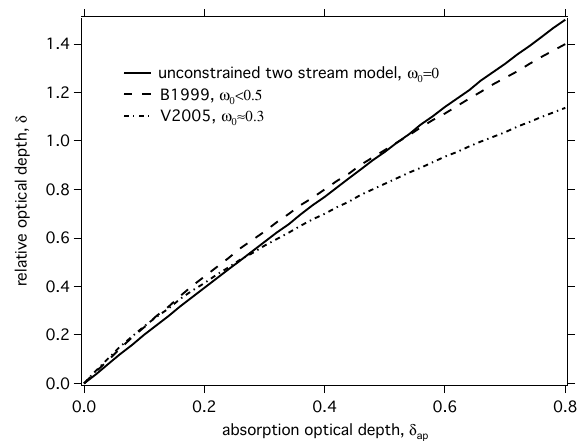
Figure 9. Comparison of the unconstrained two-stream model and experimental calibrations in B1999 and V2005. Shown are the rel- ative optical depths versus the particle absorption optical